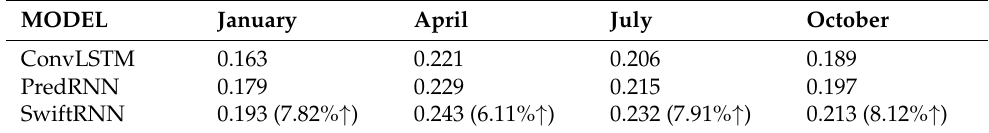
Table 5. CSI-1000 of visibility field map prediction for 4 months.